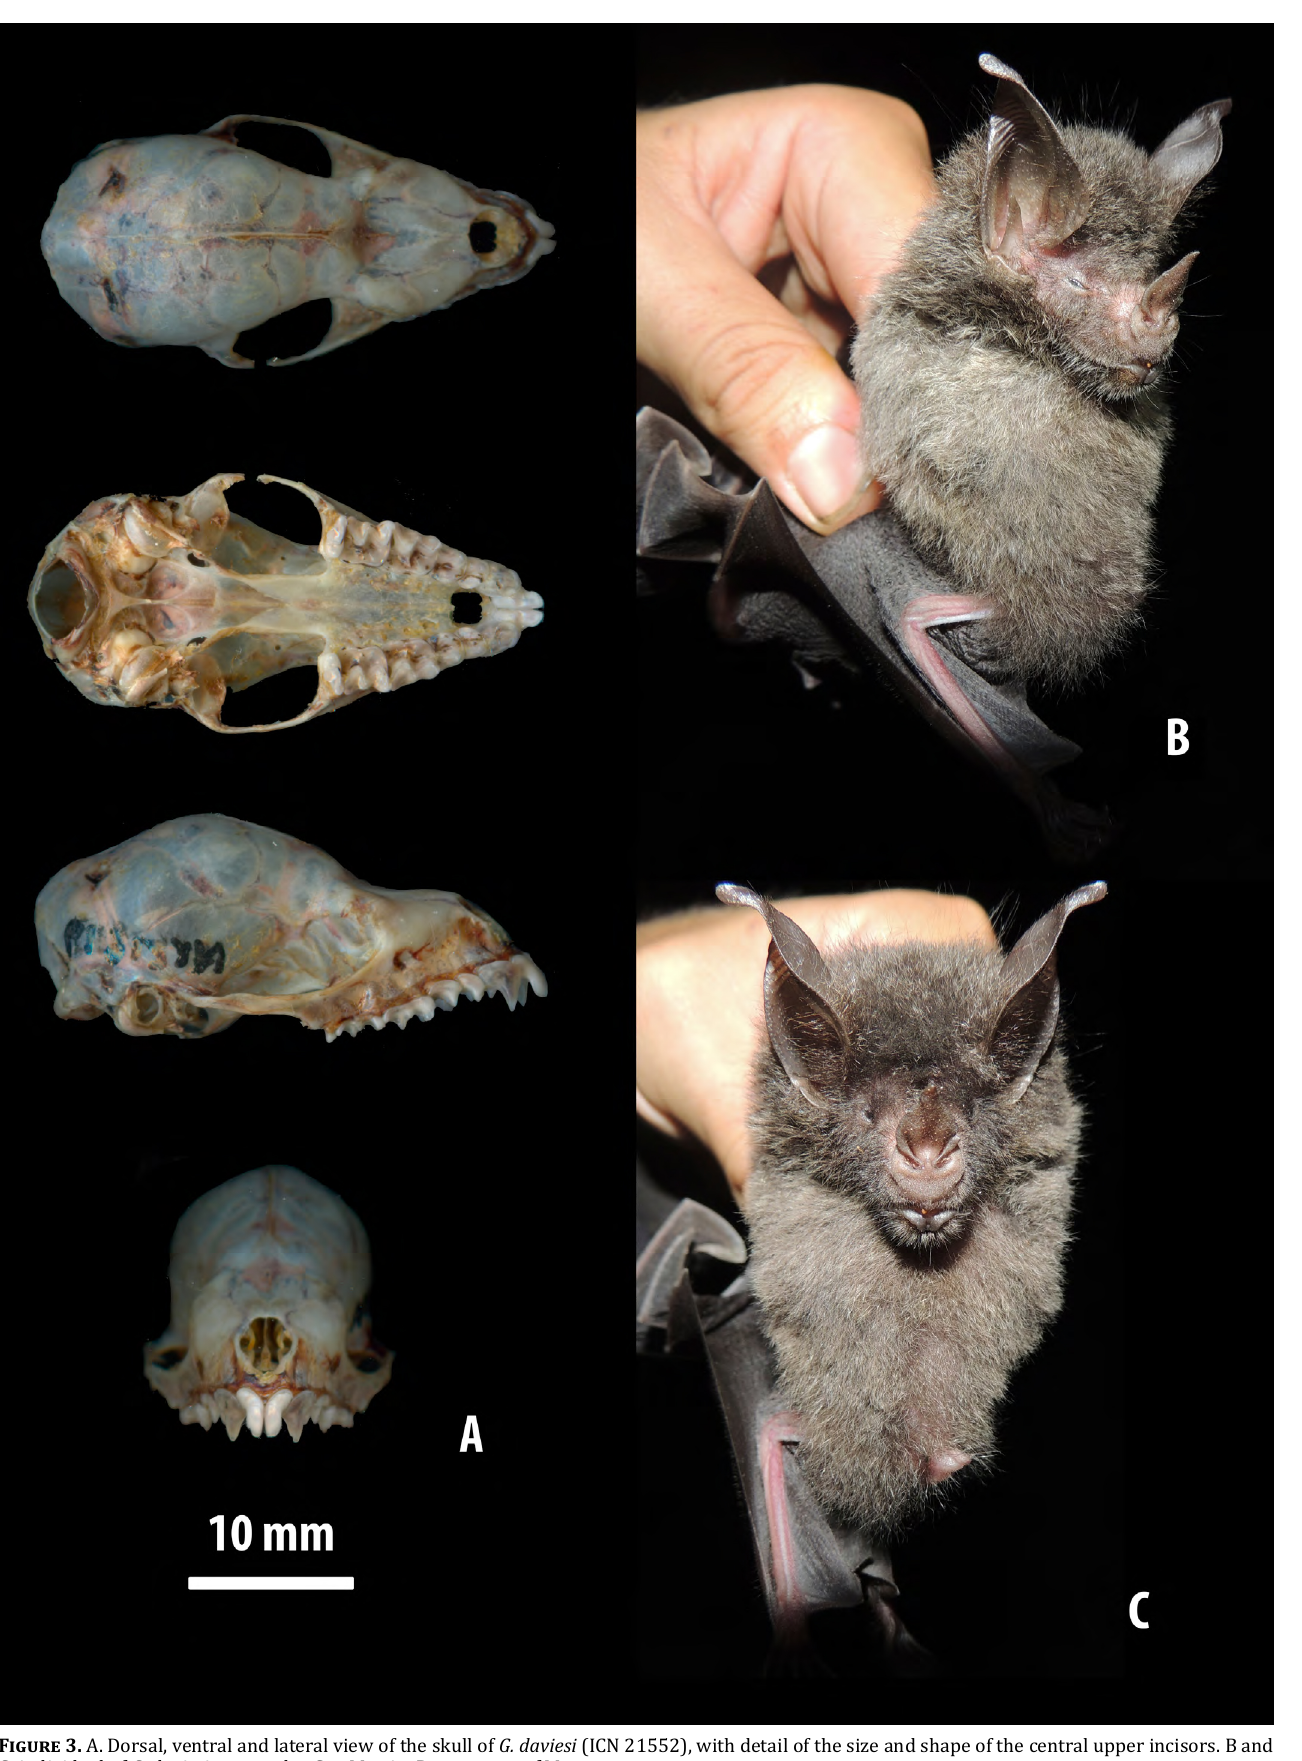
G. daviesi C: individual of captured at San Martin, Department of